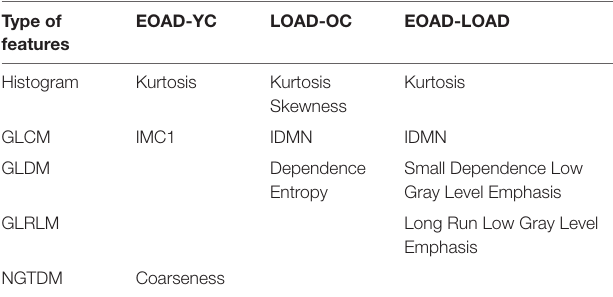
TABLE 2 | The preserved radiomic features after the feature